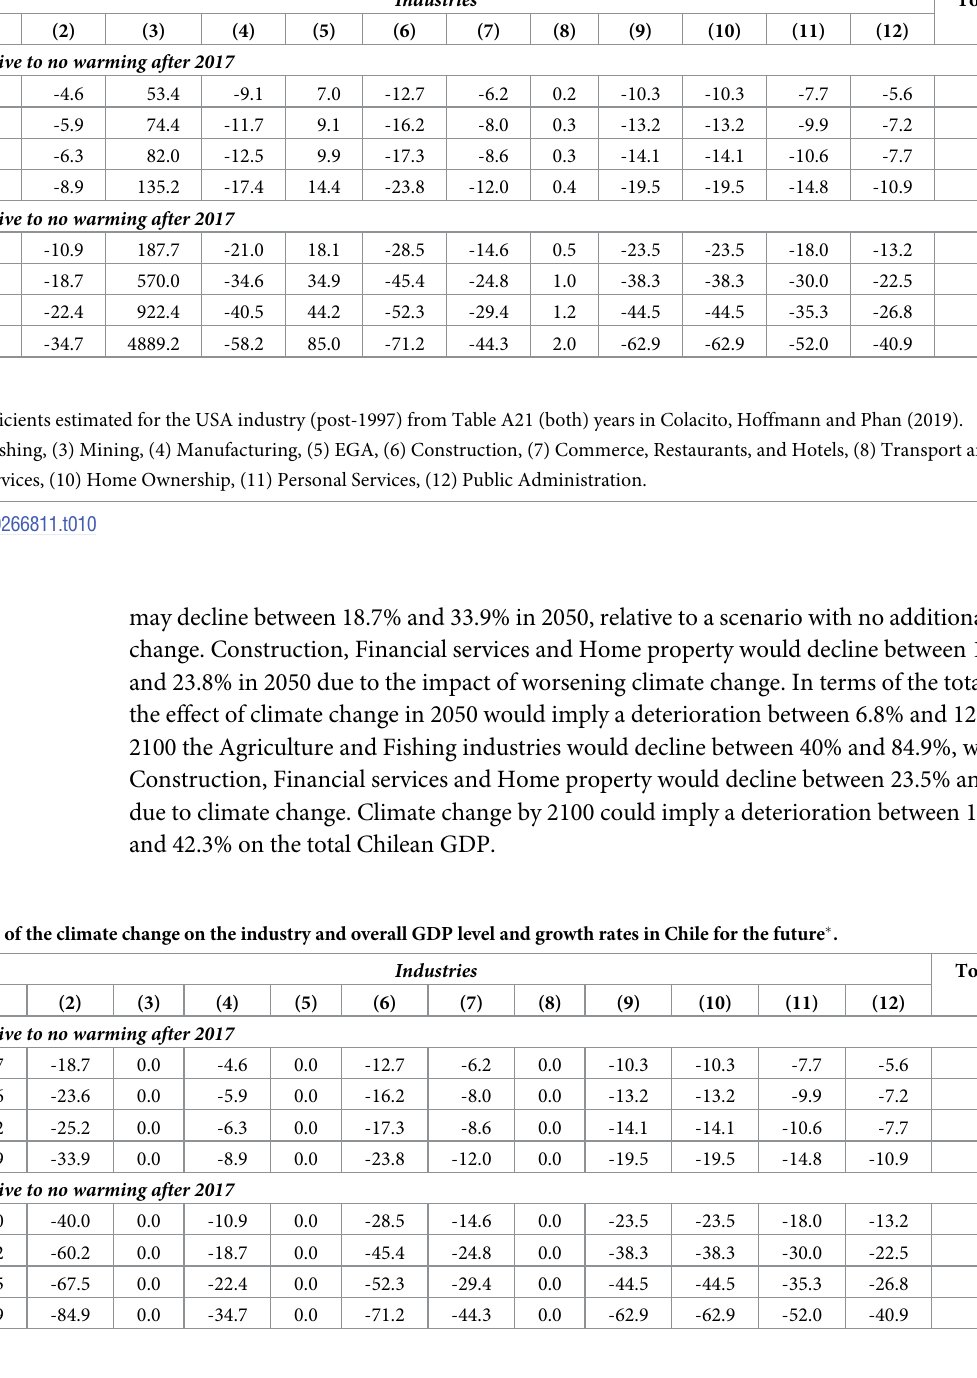
Table 10. Simulated impact (in %) of the climate change on the industry and overall GDP level and growth rates in Chile for the future � . Temperature increase Impact on GDP level in 2050 relative to no warming after